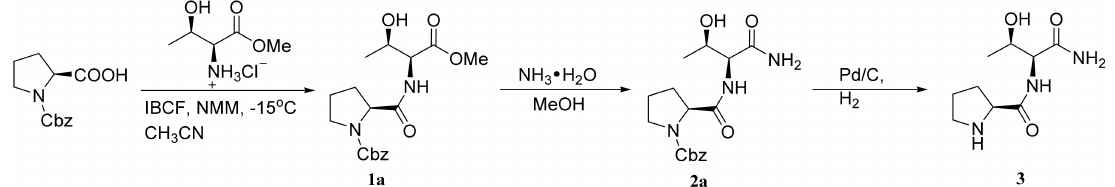
Scheme 1. The initial intended synthetic route of intermediate 3